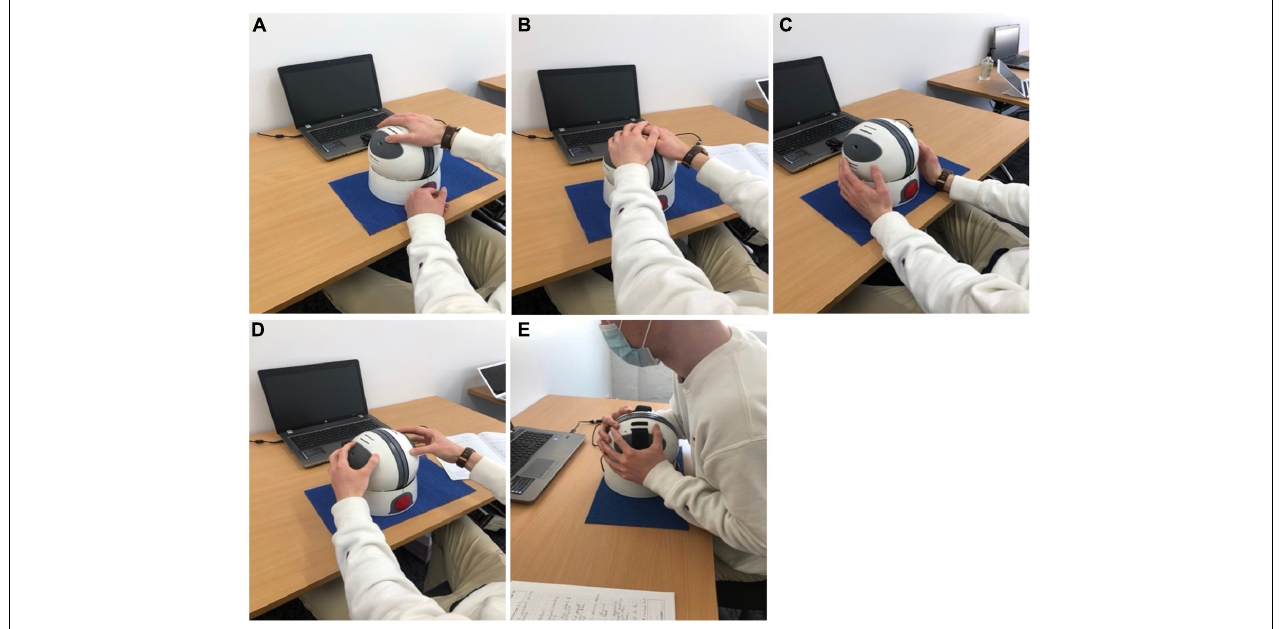
FIGURE 4 | Despite being shown a traditional grip (one hand over each grip pad) in the initial session, following additional exposures to the Orby controller, participants adopted several different techniques to control the device, including one handed (A) , upper hold (B) or lower hold (C) , fingertips (D) and bear grip (E) for those with more prominent motor